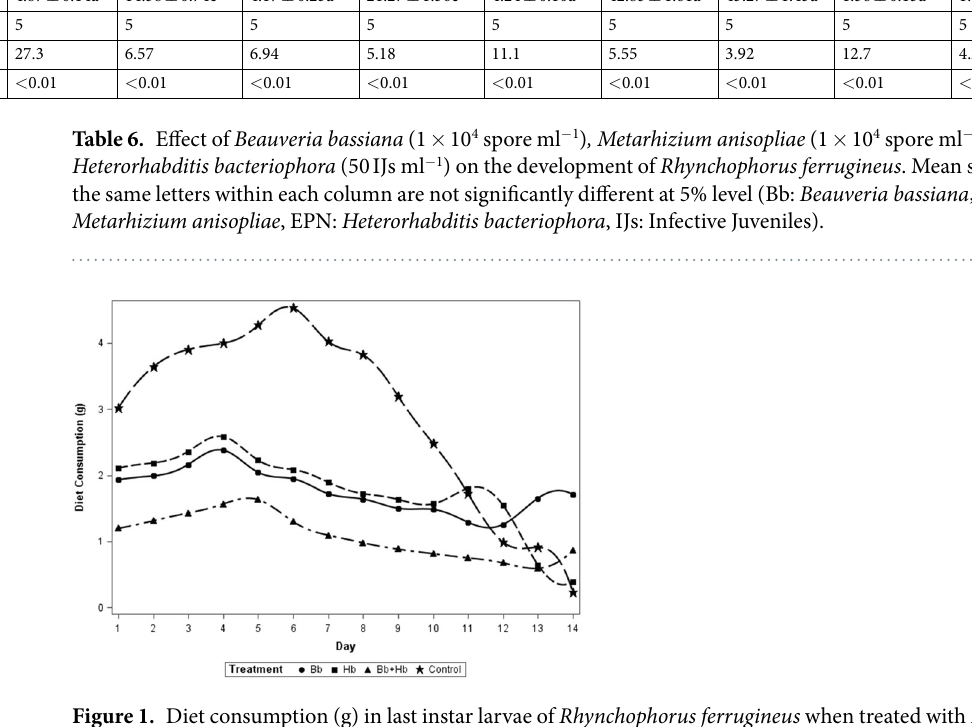
Figure 1. Diet consumption (g) in last instar larvae of Rhynchophorus ferrugineus when treated with B. bassiana (1 × 10 4 spore ml − 1 ) and H. bacteriophora (50 IJs ml − 1 ); (Bb: Beauveria bassiana , Hb: Heterorhabditis bacteriophora , IJs: Infective